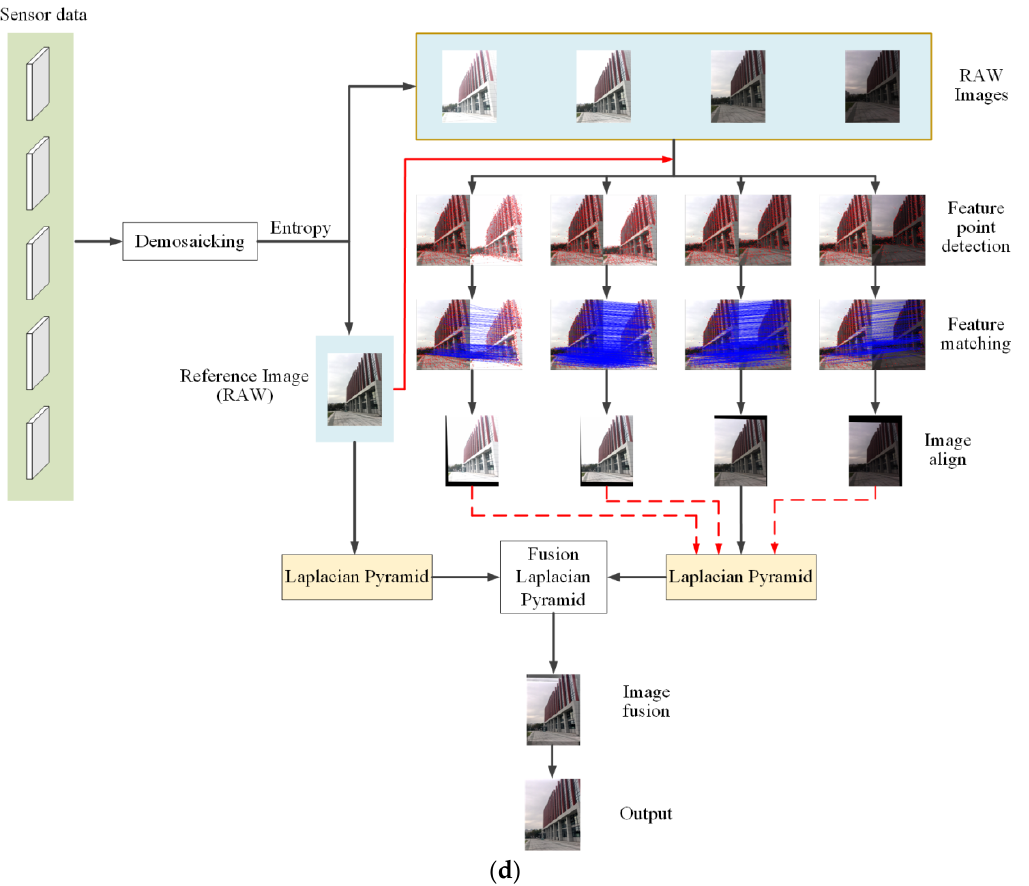
Figure 1. Different image processing pipelines. ( a ) Traditional color image processing pipeline. ( b ) Traditional direct fusion pipeline for multi-exposure images. ( c ) Improved traditional multi-exposure image fusion pipeline. ( d ) The pipeline of the proposed algorithm.